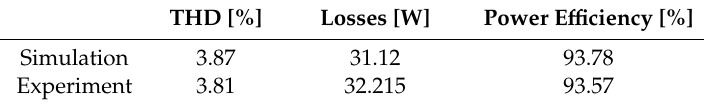
Table 5. Performances of the proposed method obtained in simulation and experimental